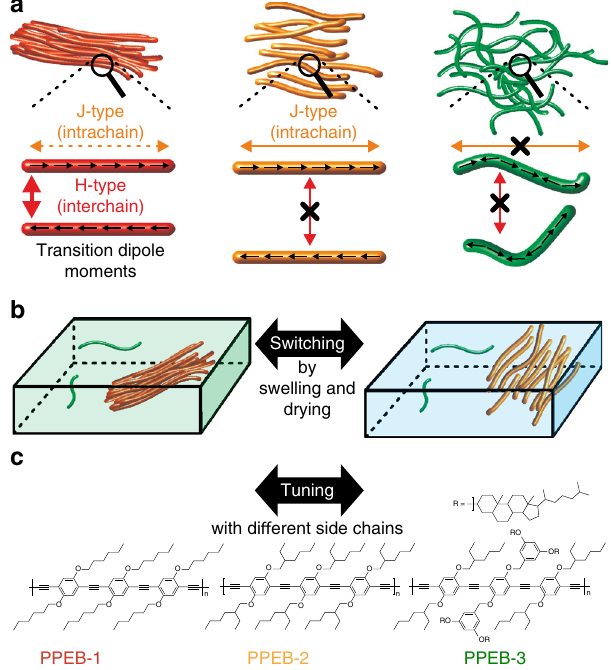
Fig. 1 Switching and tuning between different types of electronic coupling. a Mechanisms of H-type and J-type coupling and the suppression of interactions and their expected relationship with aggregate morphology. b Switching between H-type and J-type coupling by drying (green box) and swelling (blue box) the aggregate embedded inside a polymer matrix by solvent vapor annealing. c Structures of samples used to tune between